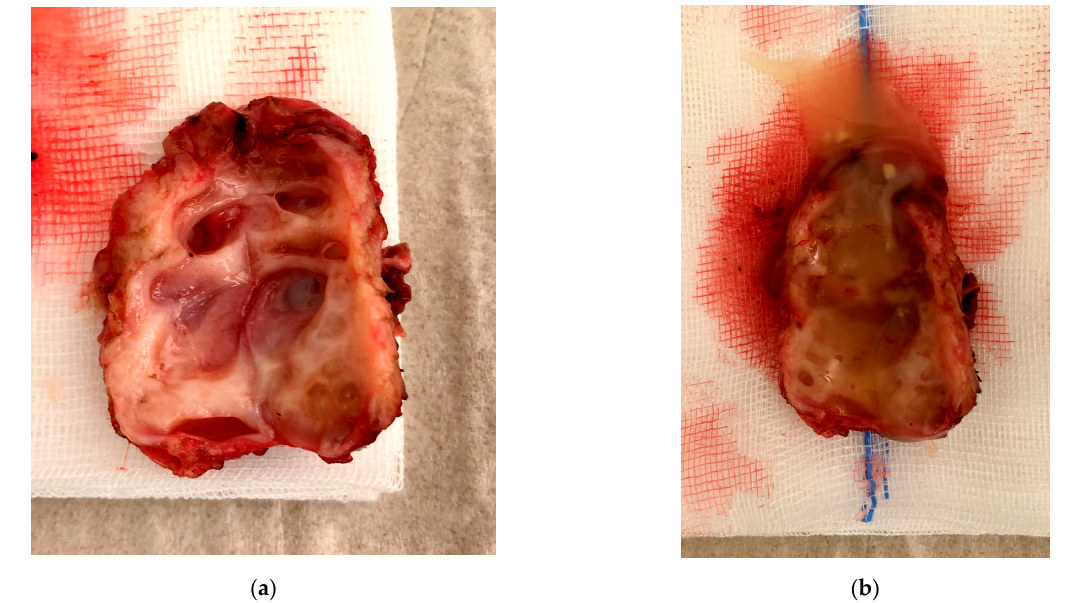
Figure 7. Specimen after resection. ( a ) inner structure of isthmocele; ( b ) isthmocele with mucus.